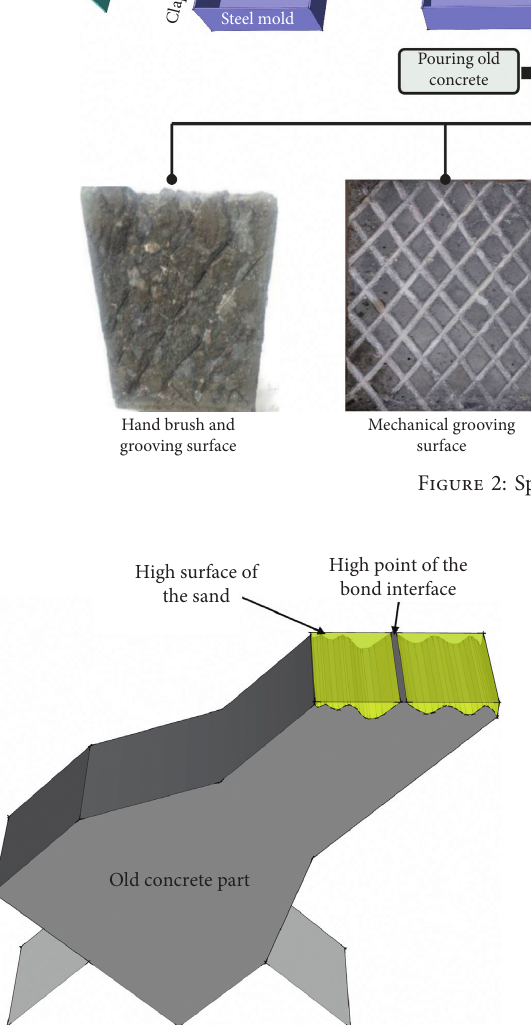
Figure 3: Sand cone